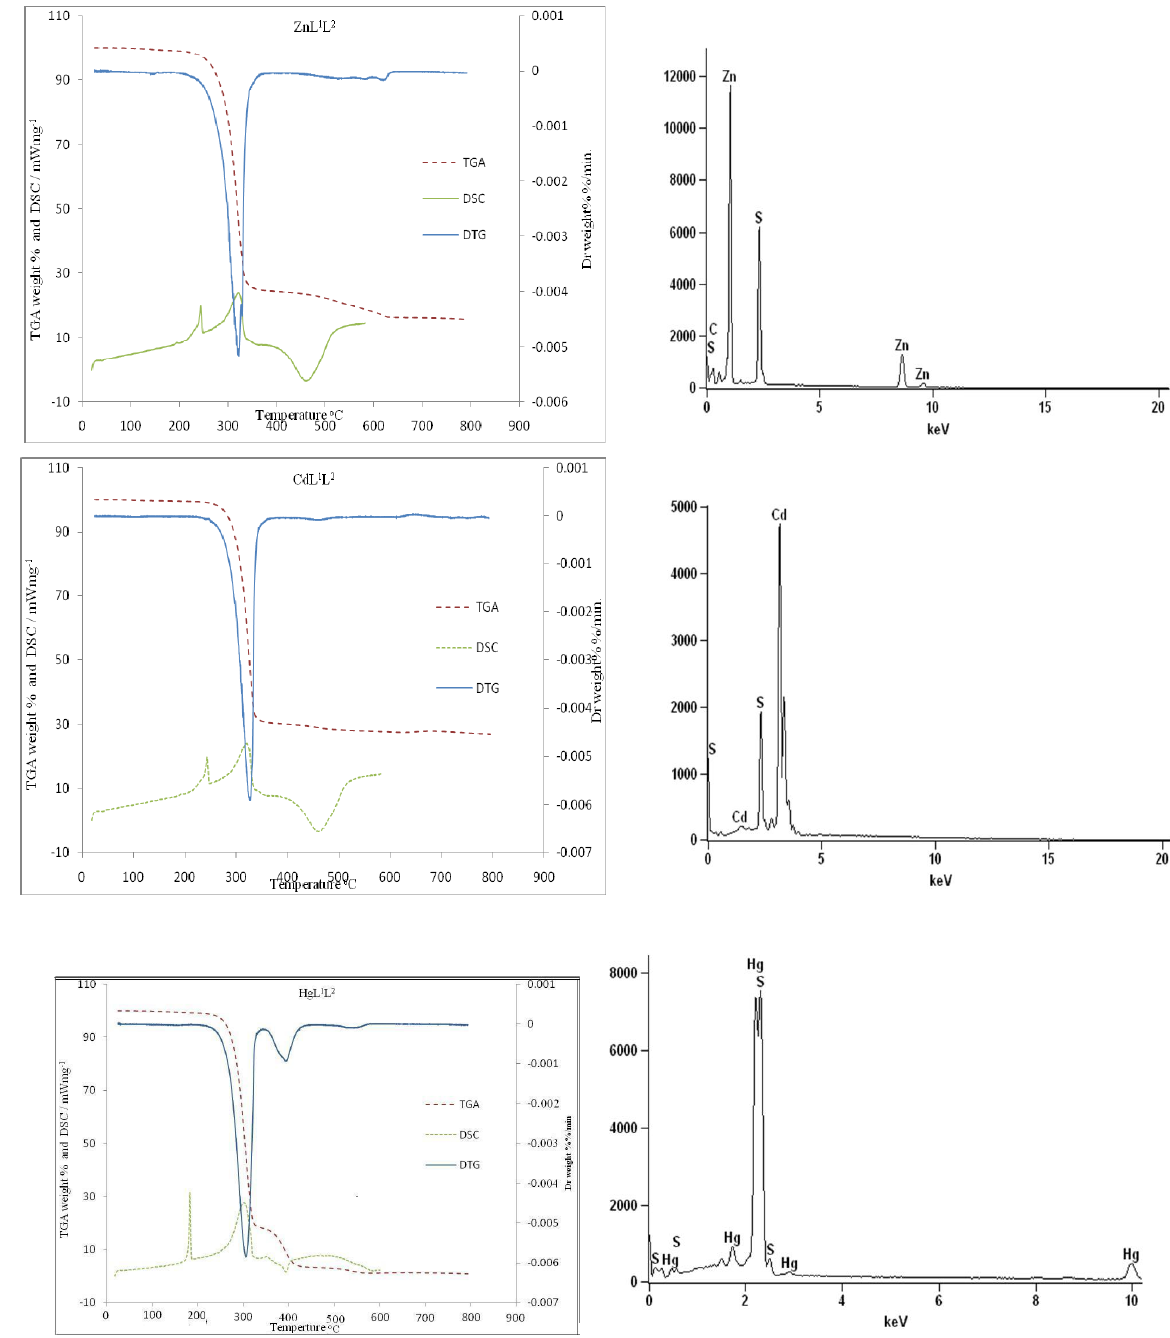
Figure 1. Thethermal gravimetric (TG), differential thermal gravimetric (DTG) and differential scanning calorimetric (DSC) curves of the complexes in nitrogen atmosphere and energy dispersive X-ray spectroscopic (EDX) analyses of the